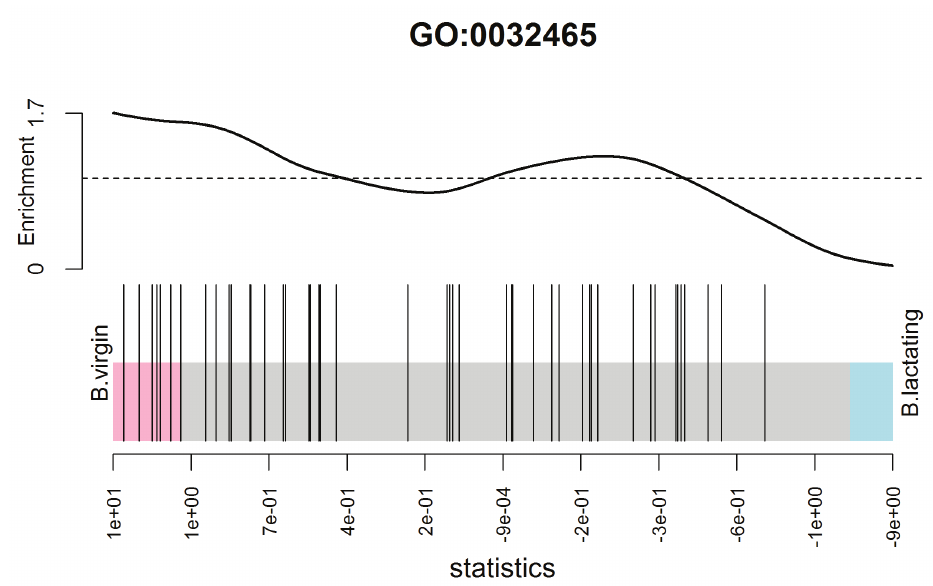
Figure 9. Barcode plot showing enrichment of the GO term GO:0032465 in the basal virgin group compared to the basal lactating group. X-axis shows logFC for B.virgin vs B.lactating. Black bars represent genes annotated with the GO term. The worm shows relative